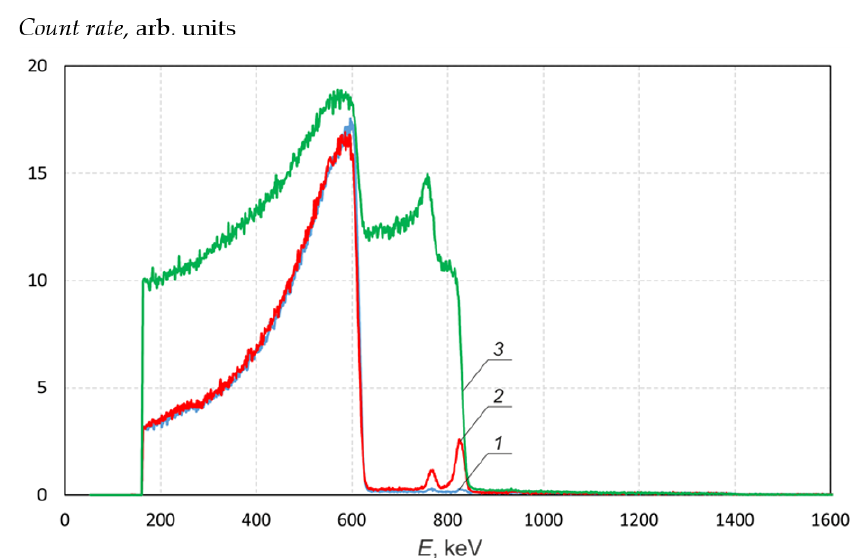
Figure 7. Signals of the alpha-spectrometer upon 1 MeV proton irradiation of the freshly deposited lithium layer on the target ( 1 ) and the lithium layer after deliberate admission of atmospheric air into the target unit for 10 min ( 2 ) and for 1 h ( 3